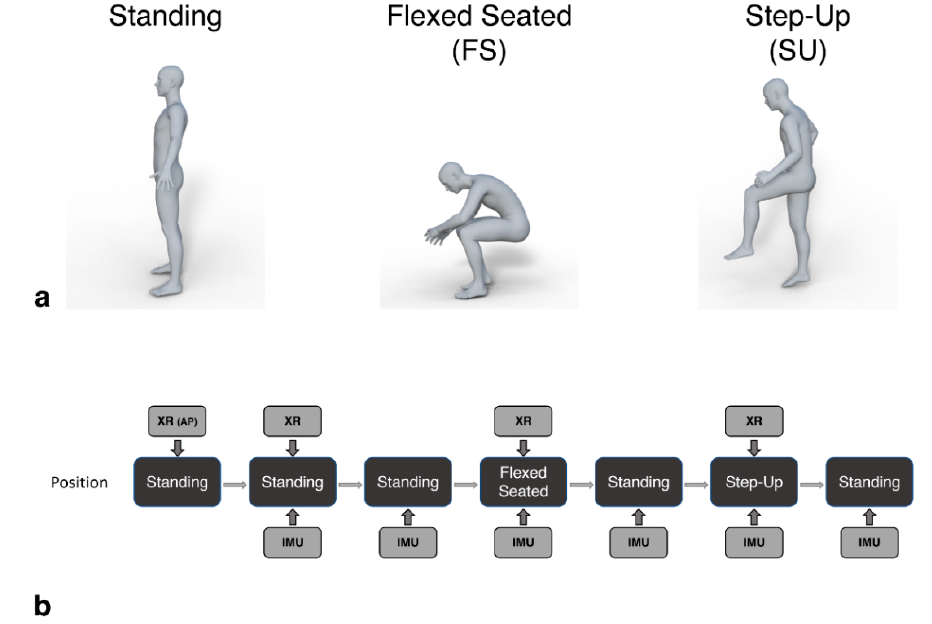
Figure 2. Patients assumed standing, flexed-seated, and step-up positions during the procedure ( a ). These positions were captured by the IMU device in parallel with lateral lumbar spine radiographs (XR), as shown in ( b ). An initial anterior pelvic radiograph was captured at the start (XR (AP)). Patients held each position for a minimum of 5 s, during which the image was taken and the IMU three-dimensional accelerations were recorded. Additional standing positions were recorded by the IMU to provide a baseline tilt measure before each radiograph.